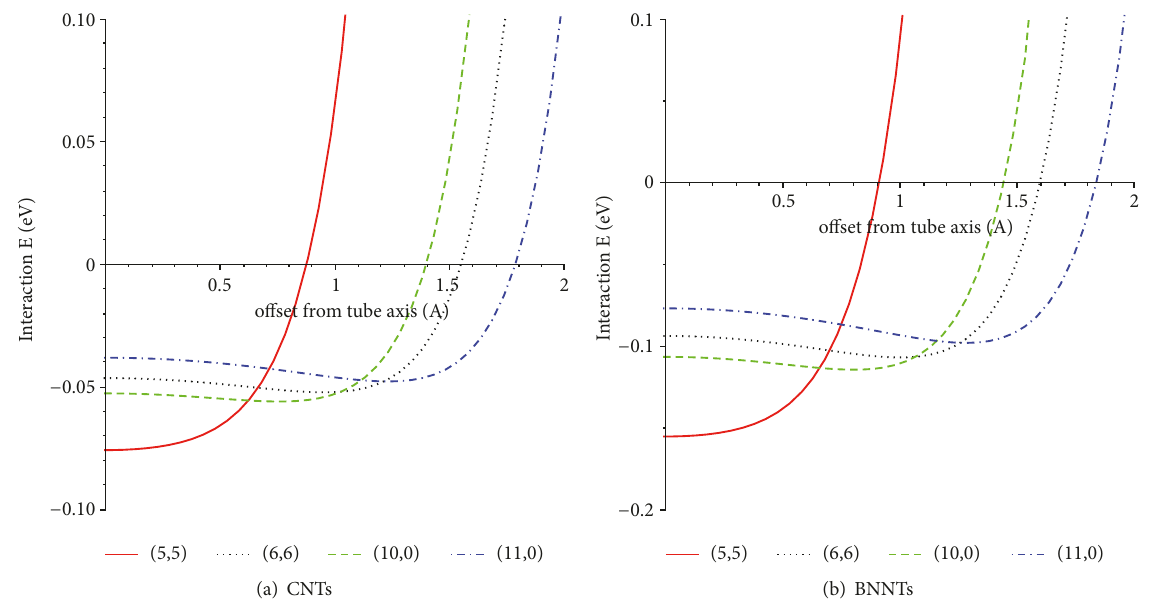
Figure 4: Total potential energy of an offset Ni atom inside CNTs and BNNTs with respect to the radial distance 𝛿